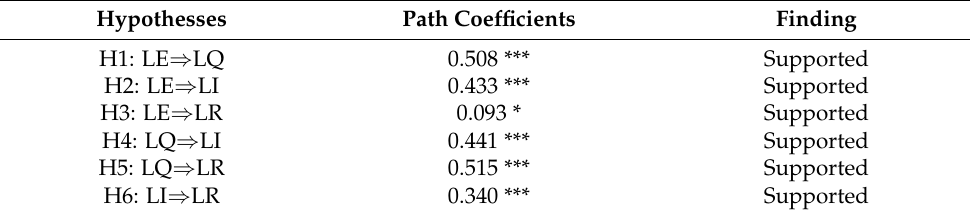
Table 6. Hypothesis testing of the research model (significant at *** p < 0.001, * p < 0.05).